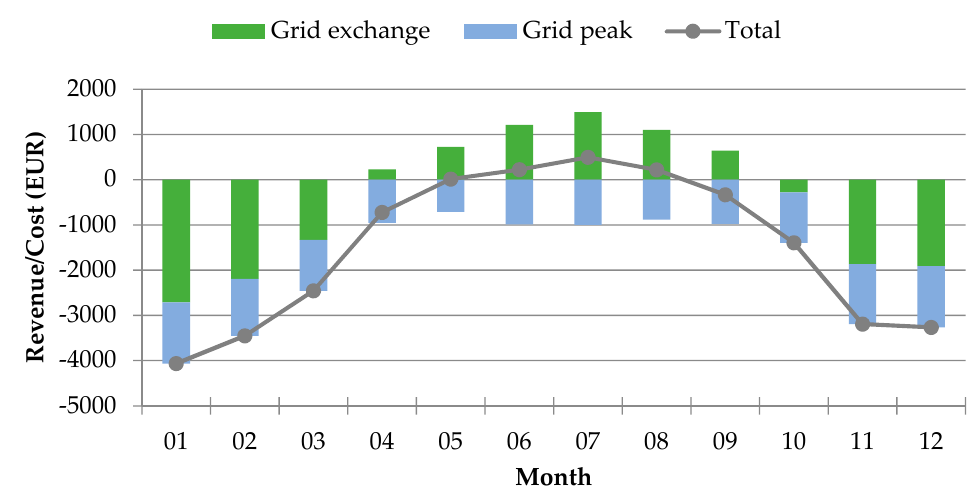
Figure 4. Battery scenario: Monthly revenue/cost results. Table 3. Yearly profitability, self-sufficiency, and share of renewables for the baseline vs battery scenarios.